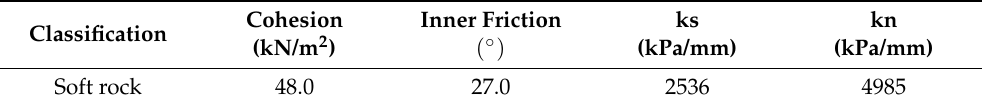
Table 3. Discontinuity material properties of soft rock.